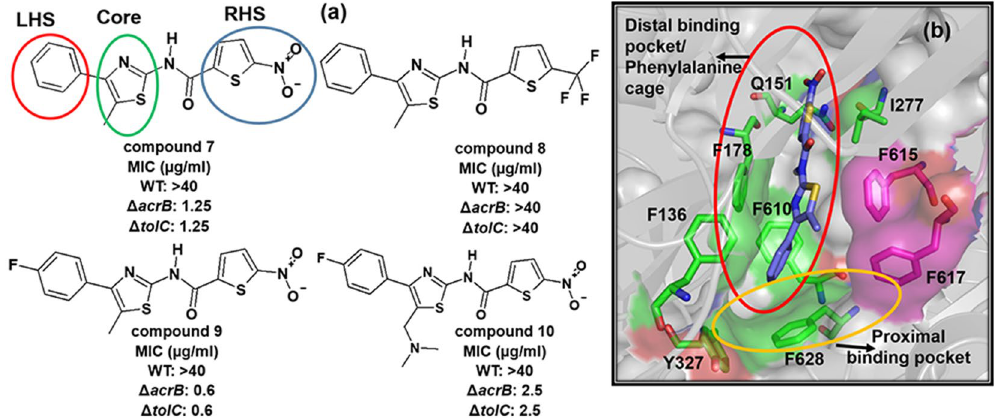
Figure 1. Initial rounds of hit optimization. ( a ) Chemical structures and associated MIC values on WT and efflux pump knockout strains. Important parts of the hit compounds are highlighted with circles and named accordingly. ( b ) Binding mode of compound 7 with AcrB efflux pump. Crucial residues of the hydrophobic pocket shown as sticks and important regions are highlighted with circles and named accordingly. The compound 7 depicted as blue